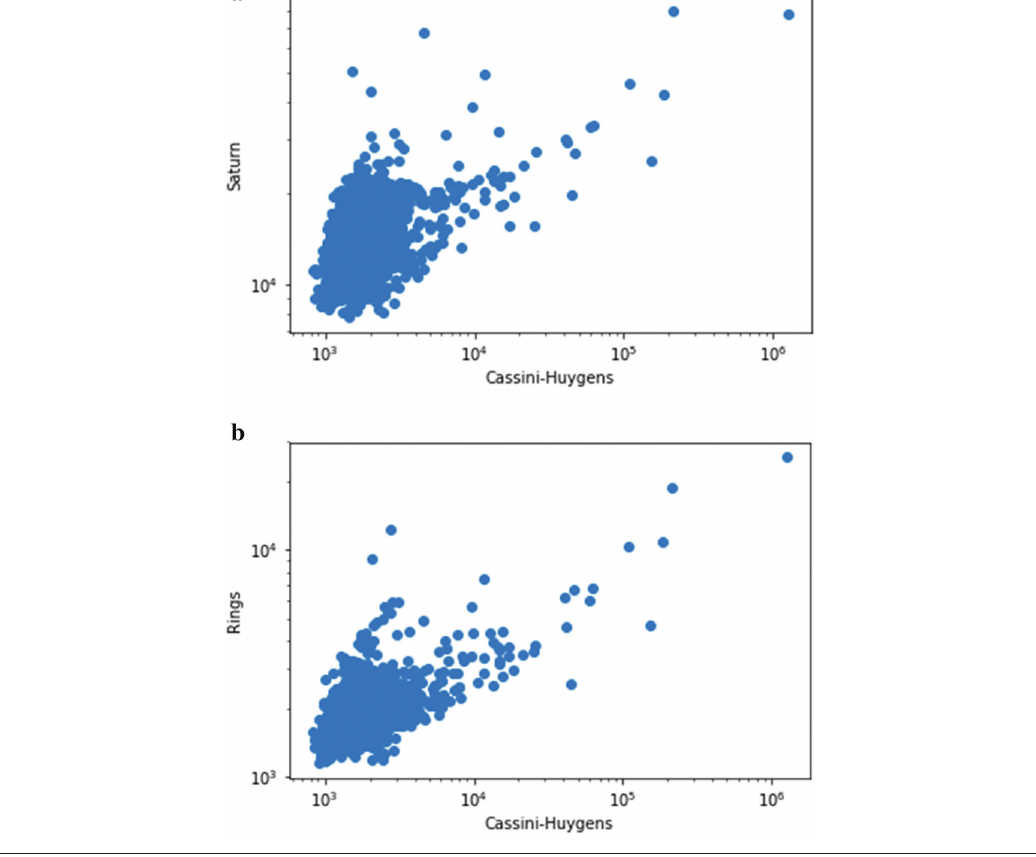
Figure 12. Viewing figures for Wikipedia articles – (a) ‘Saturn’ and (b) ‘Rings’ – plotted against the viewing figures for the article ‘Cassini–Huygens’, taken on the same day (Source: Authors,